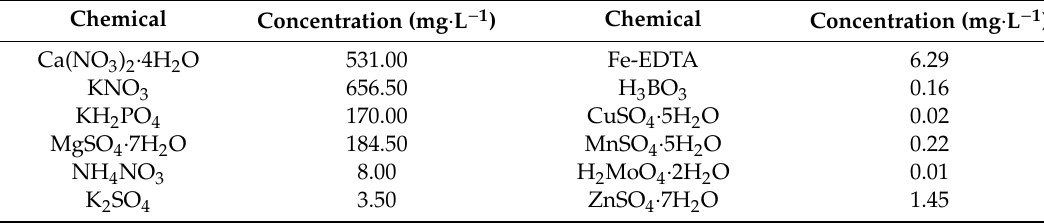
Table 1. The composition of the nutrient solution used in the